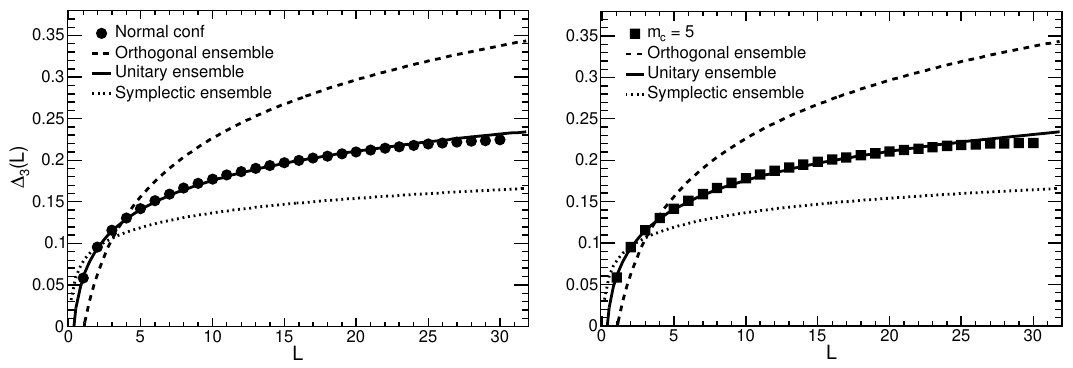
Figure 6 . The spectral rigidity (cid:1) 3 ( L ) of the normal con(cid:12)guration (left) and the con(cid:12)guration of m c = 5 (right). The results of the GOE, the GUE, and the GSE in the GRMT are represented by the dashed line, the full line, and the dotted line,